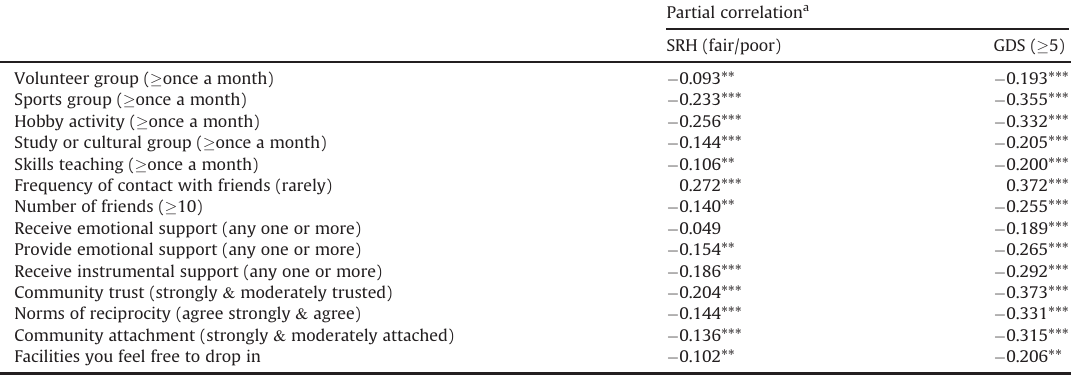
GDS, geriatric depression scale; SRH, self-rated health. *** p < 0.001, ** p < 0.01, * p < 0.05. a Population density and elderly proportion at municipality level were